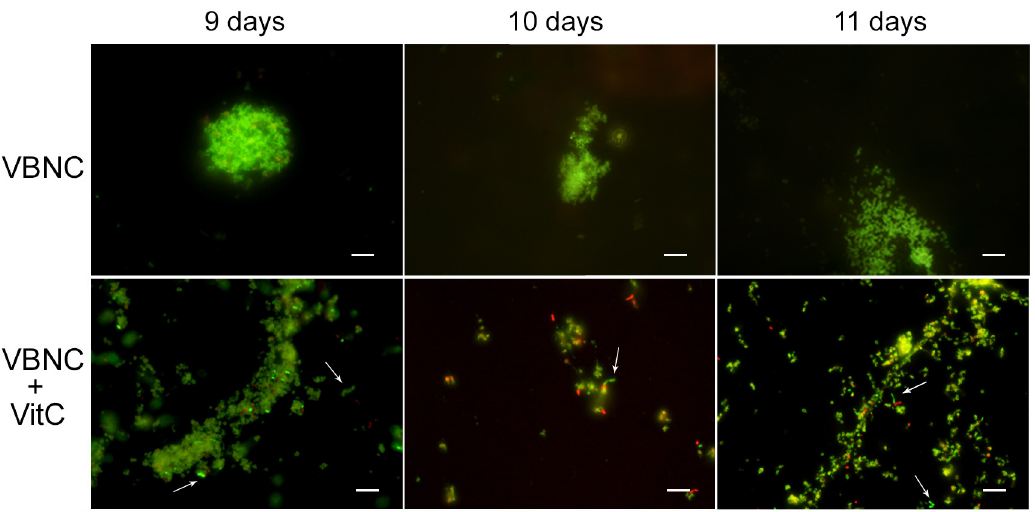
Figure 5. Effect of VitC on the VBNC state. Representative images of Live/Dead staining showing the effect of VitC on VBNC cells compared to the untreated samples (VBNC): VitC was added after 8 days of incubation after VBNC generation, and its effect was monitored for a further 24 h (9 days), 48 h (10 days), and 72 h (11 days); it was compared with the untreated sample (VBNC). The arrows indicate the viable bacillary forms in the presence of VitC. Original magnification, 1000×. For the AP state generation, VitC seems to inhibit the transition of H. pylori into the antibiotic persister state. In fact, at 48 h of incubation with AMX and VitC, not all of the bacterial population had entered the dormant phase: 1% of population remained in a spi- ral bacillary form and were viable and culturable (3.7 × 10 4 CFU/mL ± 5 × 10 3 ). The viable coccoid cells remained the most common bacterial phenotype after a further 24 h (72 h) and 48 h (96 h) of incubation (Figure 6). In this dormant state (AMX + VitC for 48 h), we again attempted treatment with 10 × MIC AMX to induce the death of the 1% of the bacil- lary population and further stress the bacterial population; during this time, the whole bacterial population was PI positive, both in bacillary and coccoid forms, inducing amor- phic forms and the production of cellular debris. The second cycle of AMX treatment guar- anteed the complete killing of the bacterial population.